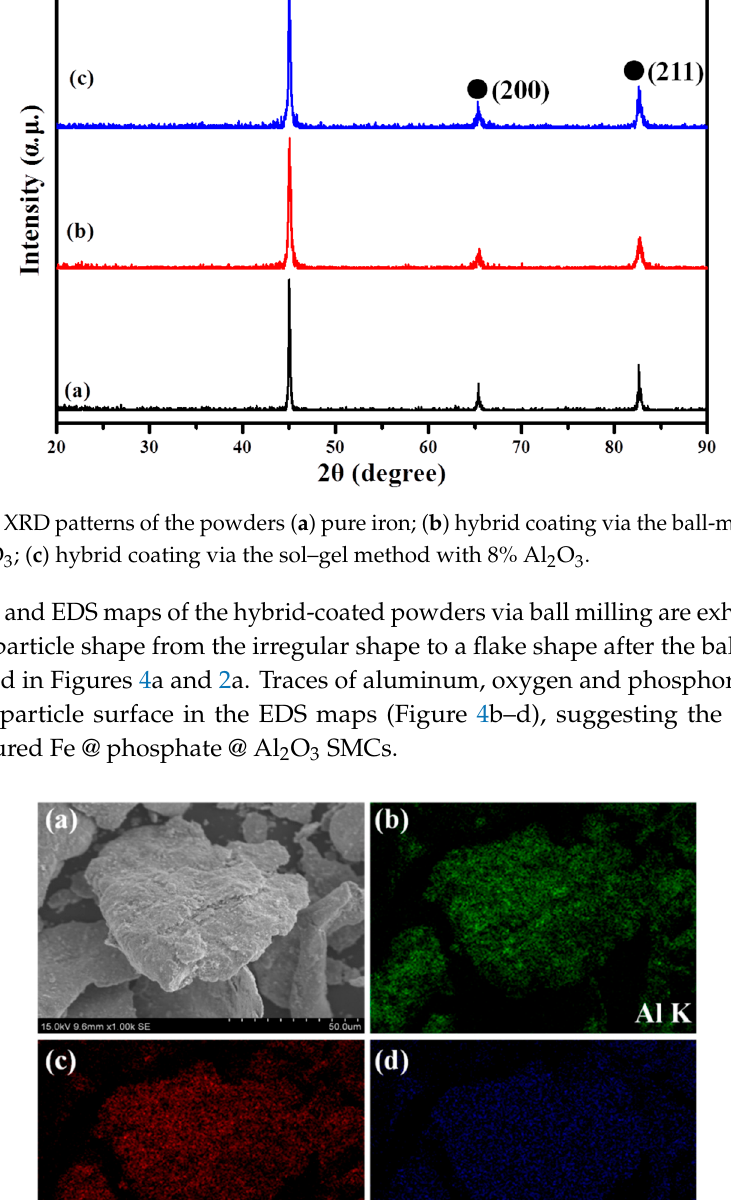
Figure 3. The XRD patterns of the powders ( a ) pure iron; ( b ) hybrid coating via the ball-milling method with 8% Al 2 O 3 ; ( c ) hybrid coating via the sol–gel method with 8% Al 2 O 3 . The XRD patterns of the pure iron particles and the hybrid-coated particles are displayed in Figure 3. The diffraction peaks at 2 θ = 44.667°, 65.000° and 82.366° correspond to the (110), (200) and (211) planes of the α -Fe phase (JCPDS 06-0696). The XRD patterns of the coated powders are not